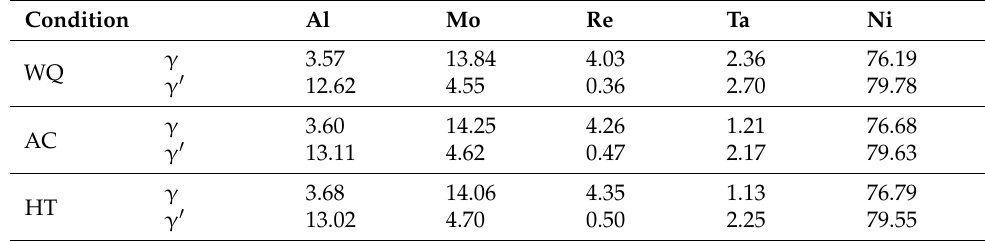
Figure 14. The lattice misfit and dislocation network spacing after 10 h of creep interruption at 1100 °C/137 MPa, and denser dislocation networks showed longer creep life.